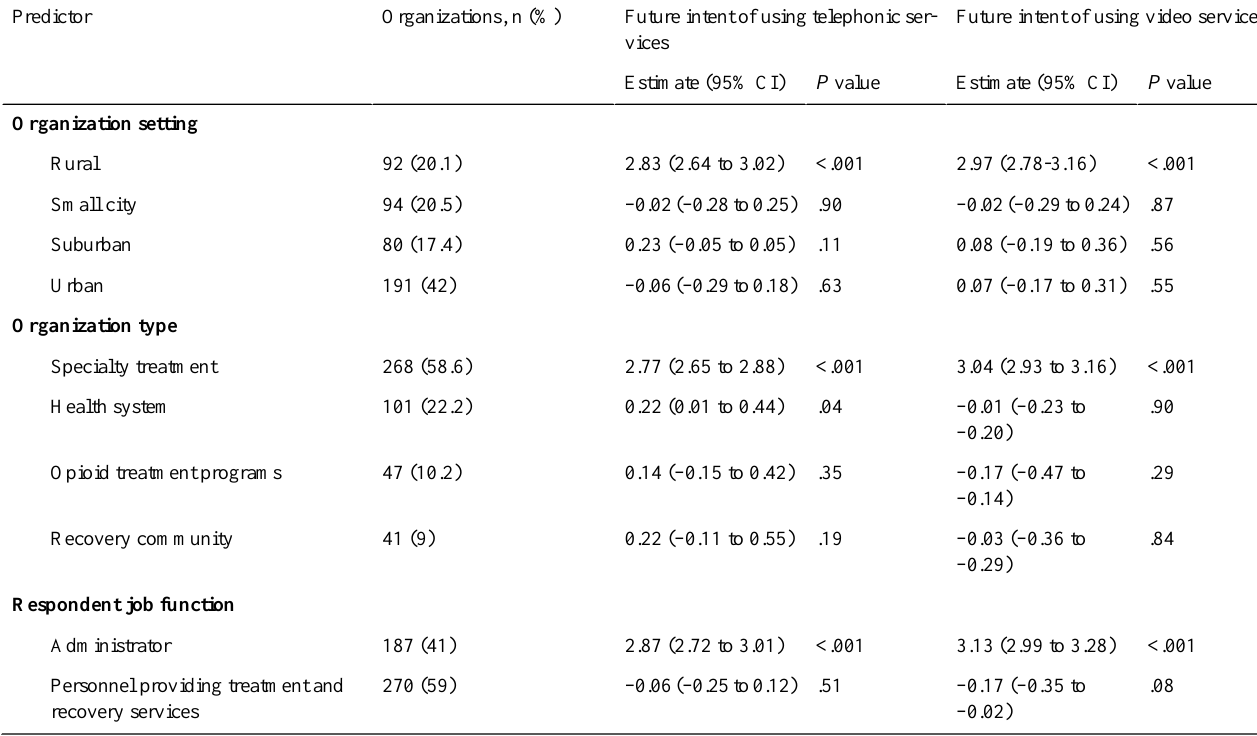
Table 1. Characteristics of the participating organizations (N=457).